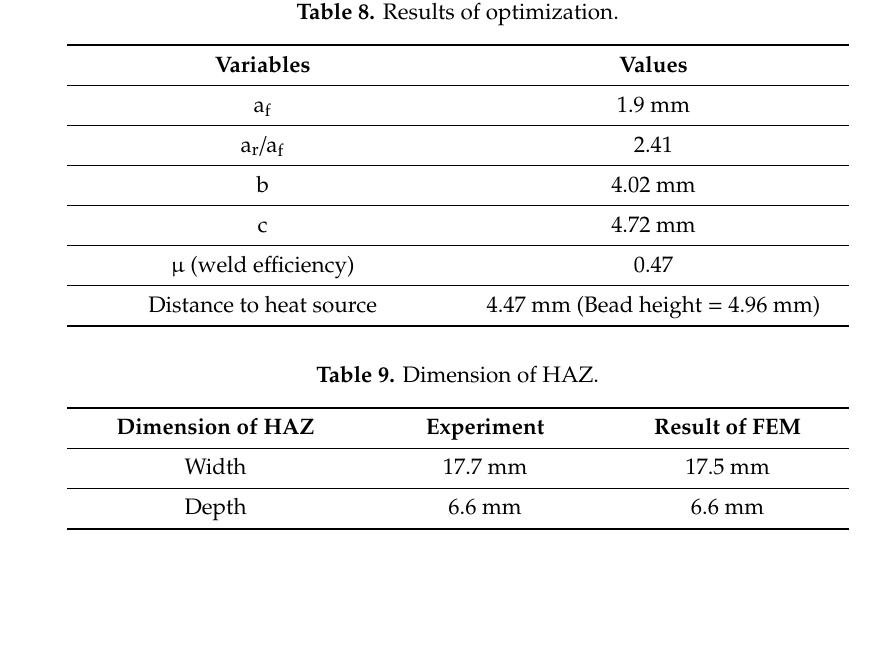
Table 10. Analysis results by measurement location.